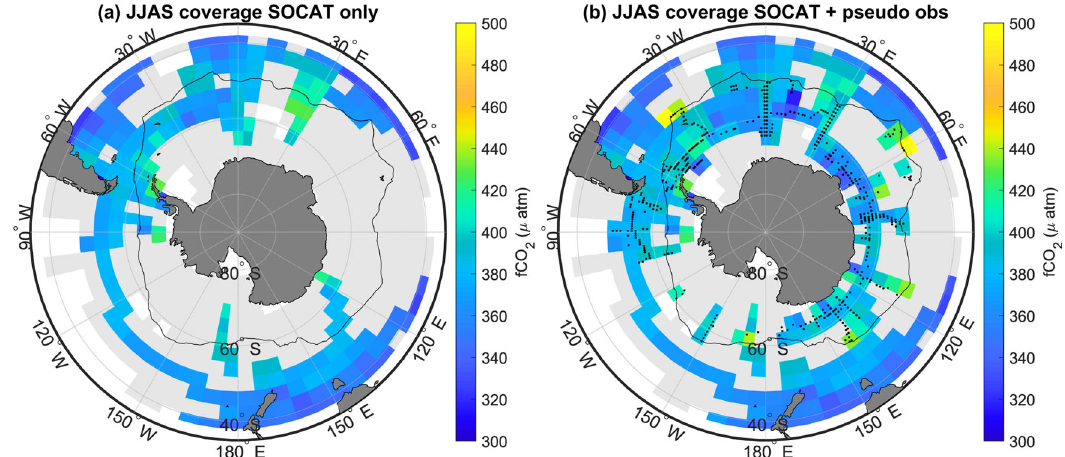
Fig. 1 Southern ocean fCO 2 data coverage. a Colour shows wintertime (June-September) observations of sea surface fCO 2 (in micro-atmosphere, µ atm) from SOCAT south of 35°S from 2004 to 2018, binned and averaged onto a 4° latitude by 6° longitude grid. b As a but with the addition of wintertime pseudo fCO 2 observations constructed for the same period. Light grey shading shows the coverage of all non-wintertime SOCAT fCO 2 observations for the same years on the same grid, and the black dots are the locations of the pseudo observations on the 1° × 1° grid used to train the SOM-FFN. The black lines show the mean position of the polar front from a published product 62